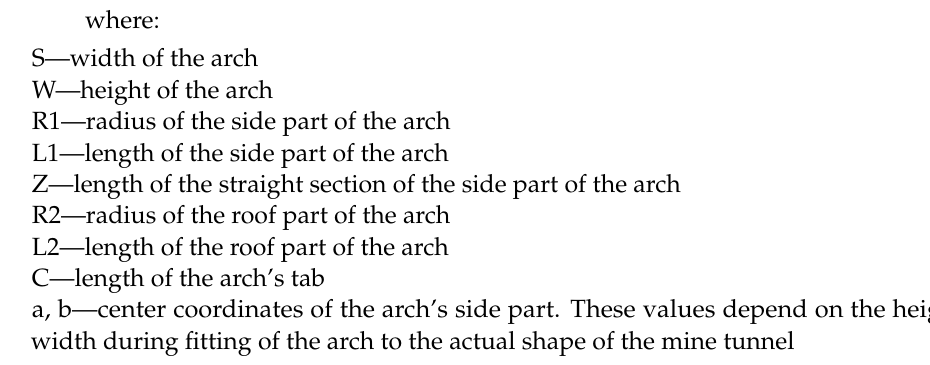
Table 1. Data for arch yielding support 8-KS/KO-21.